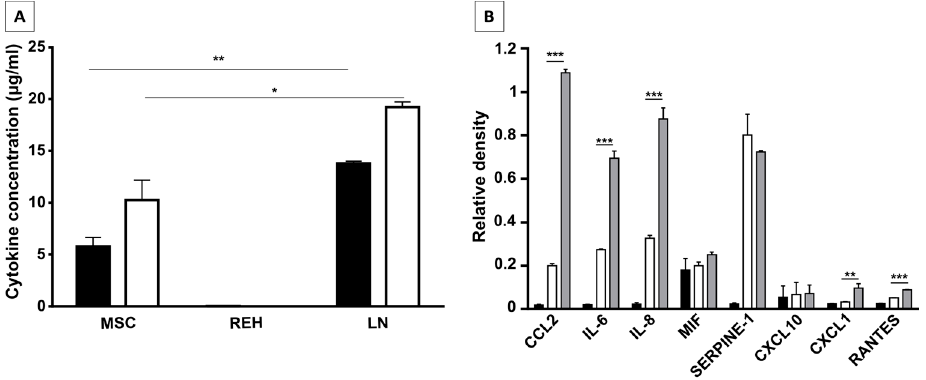
Figure 7. Identification and quantification of cytokines present in leukemic microenvironment. ( A ) IL-6 (white bar) and IL-8 (black bar) quantification in CM of MSC, REH, and LN. Quantification of cytokines was made by CBA (cytometric bead array, Human Inflammatory Cytokines Kit, BD) after 24 h of monocultures (MSC or REH) and co-cultures (LN) with 1% of FBS. ( B ) Cytokines present in the CM of REH cells (black bar), MSC (white bar), and LN (grey bar) were observed by microarray analysis. Relative densities are shown compared with positive control spots. Identification of cytokines present in LN was made by Proteome Profiler Array (Human Cytokine Array) R and D Systems. Data were obtained from the two independent experiments done in duplicates ( n = 4) (* p < 0.05, ** p < 0.01, *** p < 0.001).